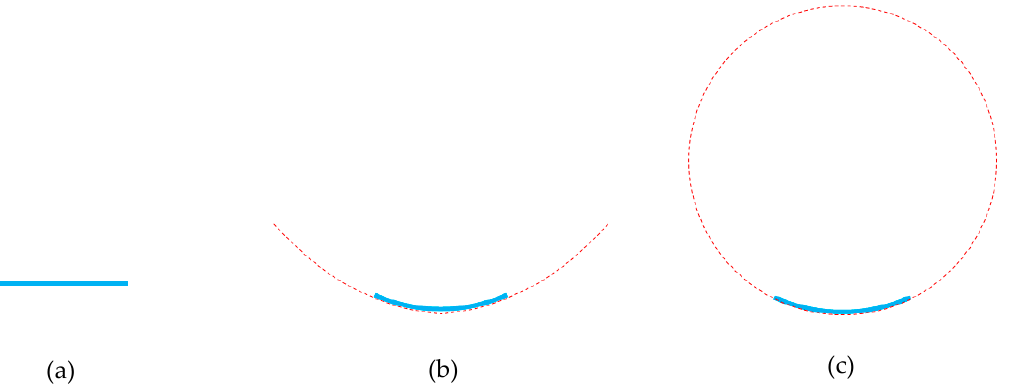
Figure 1. Scheme of the three mirror’s shape addressed: ( a ) flat-shape mirrors, ( b ) parabolic-shaped mirrors, and ( c ) cylindrical-shaped mirrors.